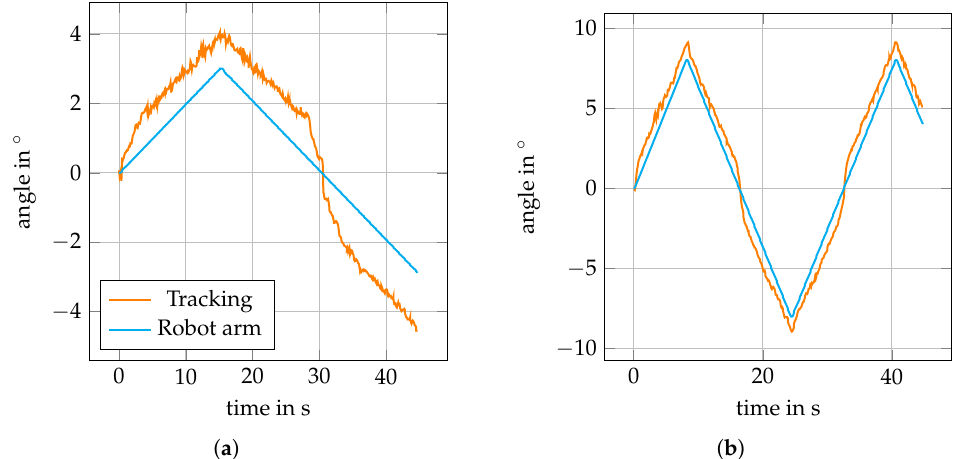
Figure 13. The tracking system (orange) systematically overestimates the robot angles (cyan) for out-of-plane rotations with different maximum angles at 0.2 ◦ /s ( a ) and at 1 ◦ /s ( b ). Learning rate η = 0.02 is used.